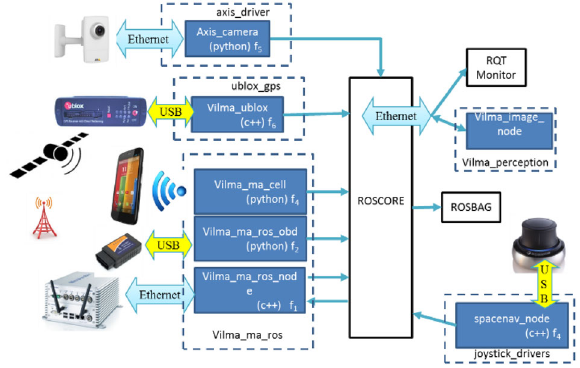
Fig. 5 Nodes executed in ROS for VILMA01